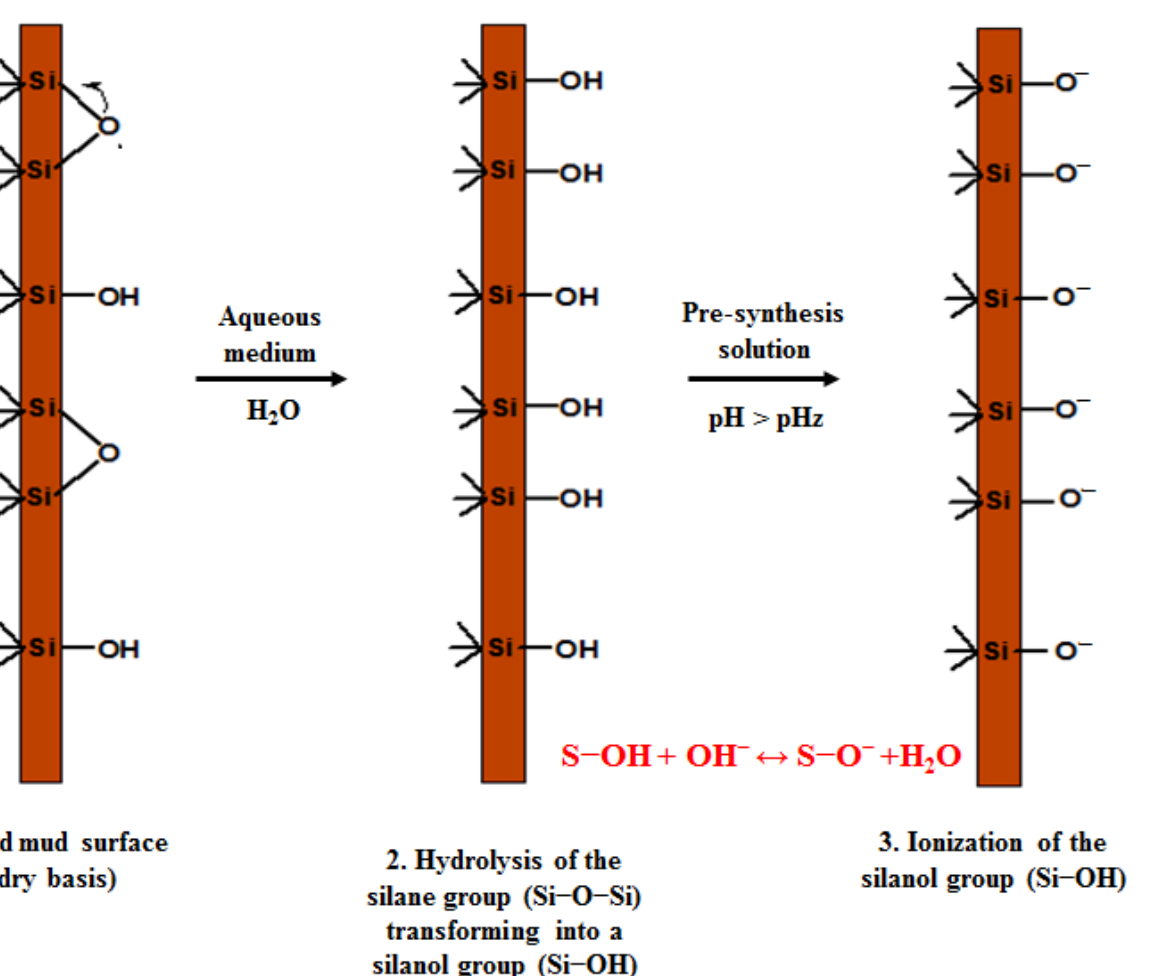
Figure 13. Reactions of the inorganic phases in the pre-synthesis suspension.